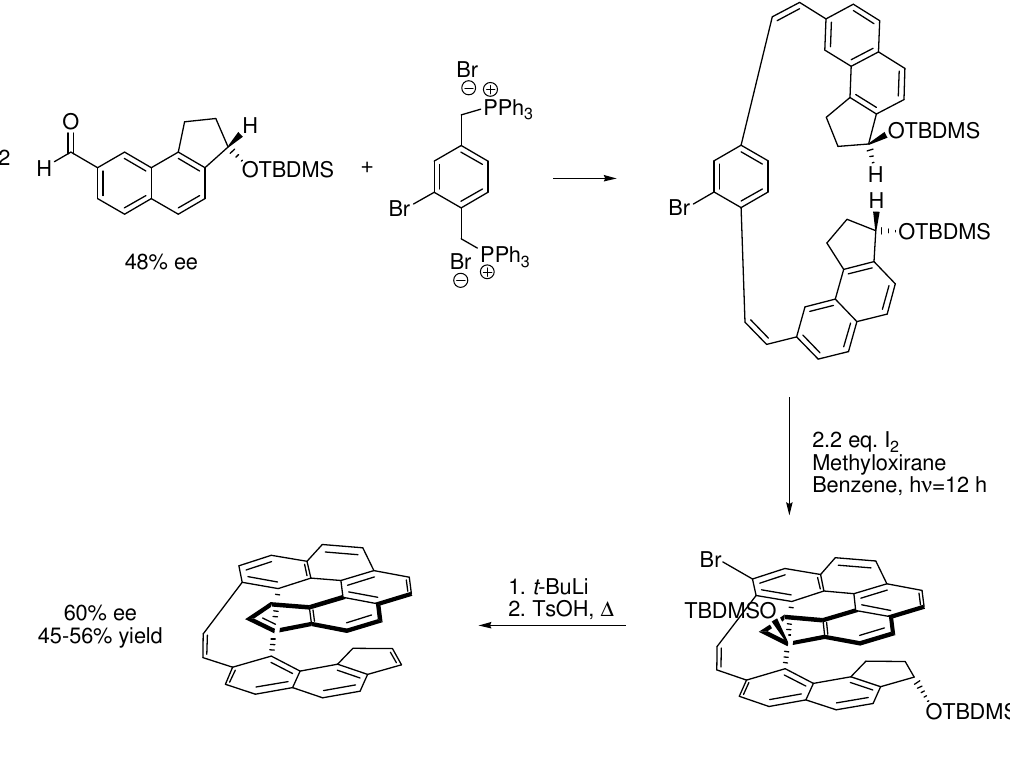
Scheme 14. Synthesis of a chiral helicene-system obtained with a double Mallory-reaction with Br as a blocking group. The two chiral groups get placed on the outside of the helicene to avoid unnecessary bending of the aromatic system [16].